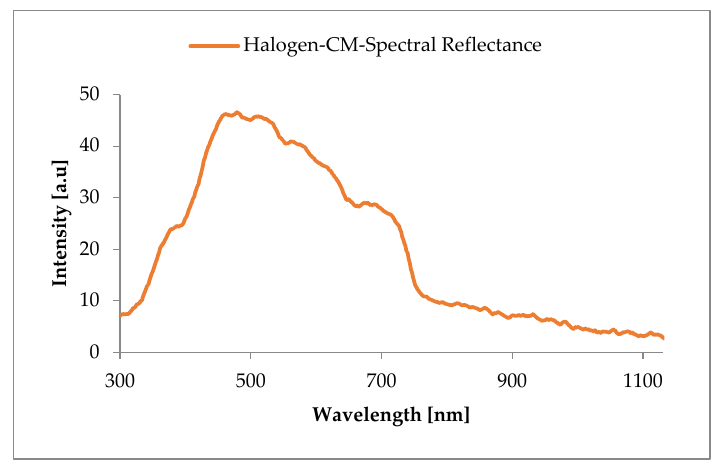
Figure 7. The halogen light spectrum reflected by the cold mirror.